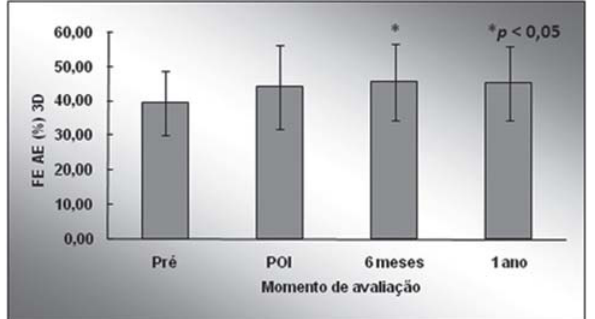
Fig. 5. Evolução do volume diastólico final do átrio esquerdo (AEVDF) durante o estudo. Observamos redução significativa no AEVDF entre o momento Pré (pré-operatório) e POI (pós-operatório imediato). Essa redução permanece estável durante o estudo. Valores = média ± desvio-padrão. * P < 0,05 em relação ao POI